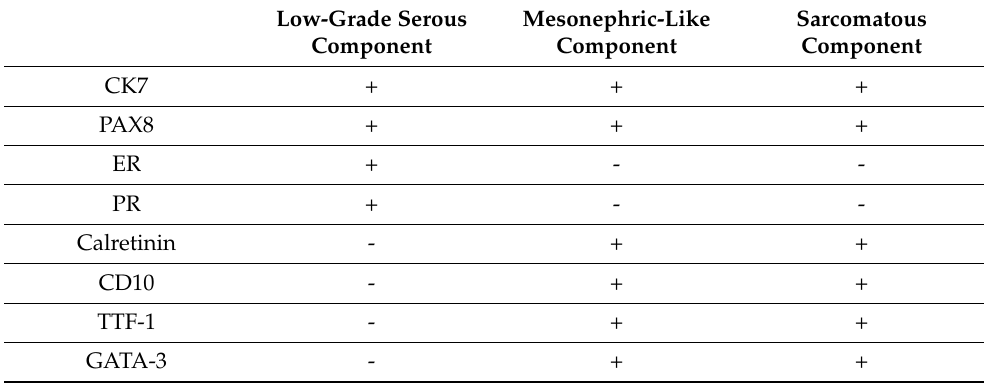
Figure 6. Immunohistochemical results of chondrosarcomatous component: ( a ) CK7; ( b ) PAX8; ( c ) ER; ( d ) PR; ( e ) Calretinin; ( f ) CD10; ( g ) TTF-1; ( h ) GATA-3. (200 × ). Table 1. Immunohistochemical results of the different tumor components (legend: + = positive immunohistochemical result, - = negative immunohistochemical